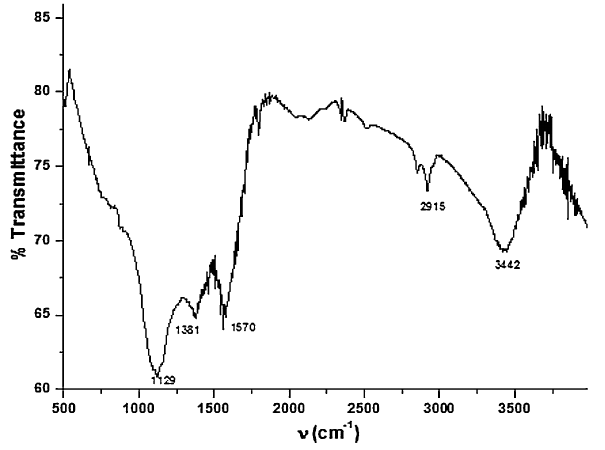
Fig. 2 FT-IR spectrum of C-ZMN adsorbent